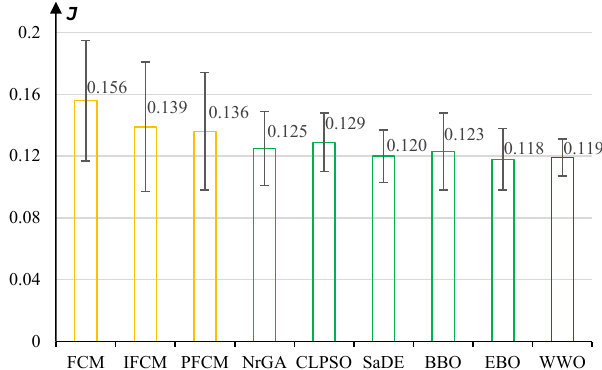
Figure 7. Average J ( U , V ) values and standard deviations of the clustering results of the comparative algorithms for moth